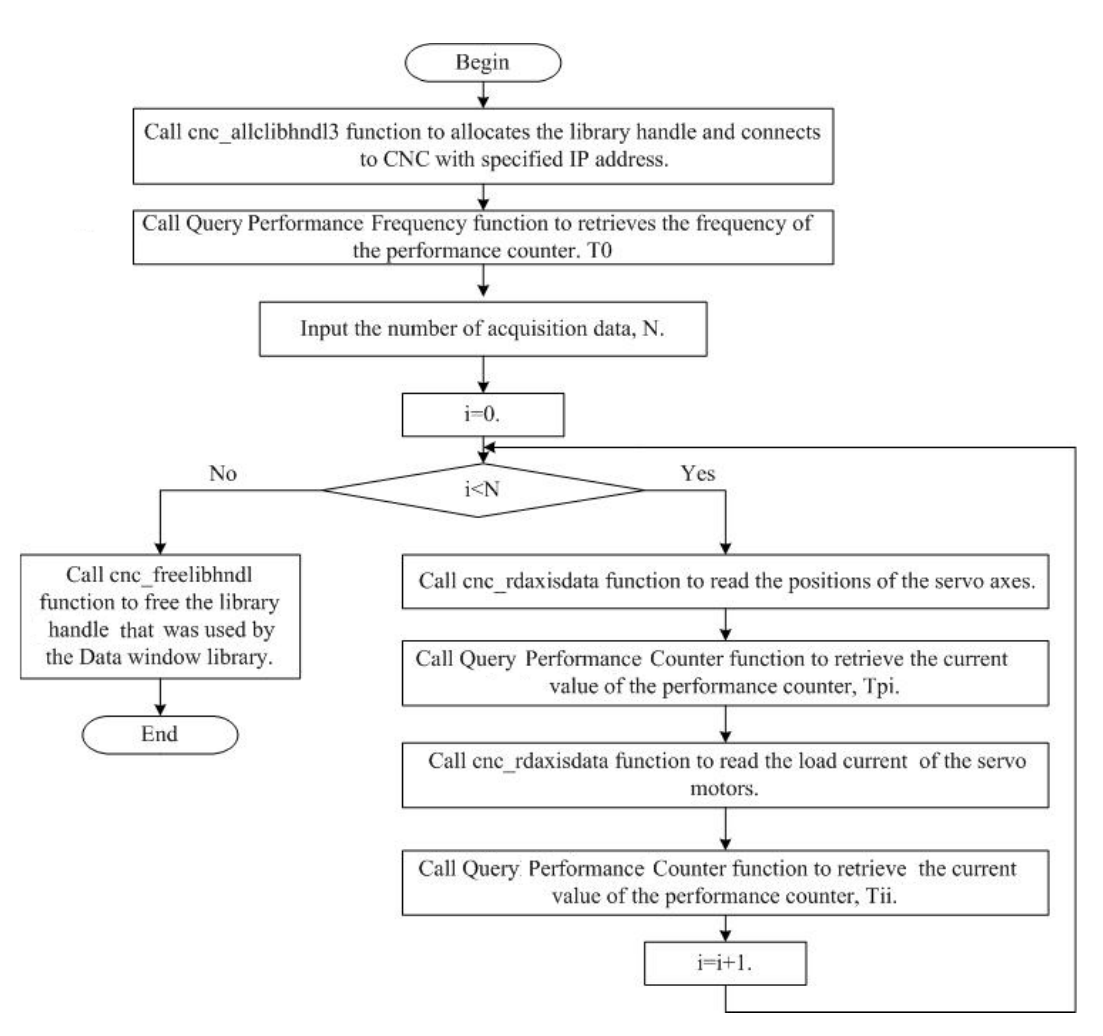
Figure 3. Block diagram of the data collection application program. Table 1. Specifications for the ball screw drive system.